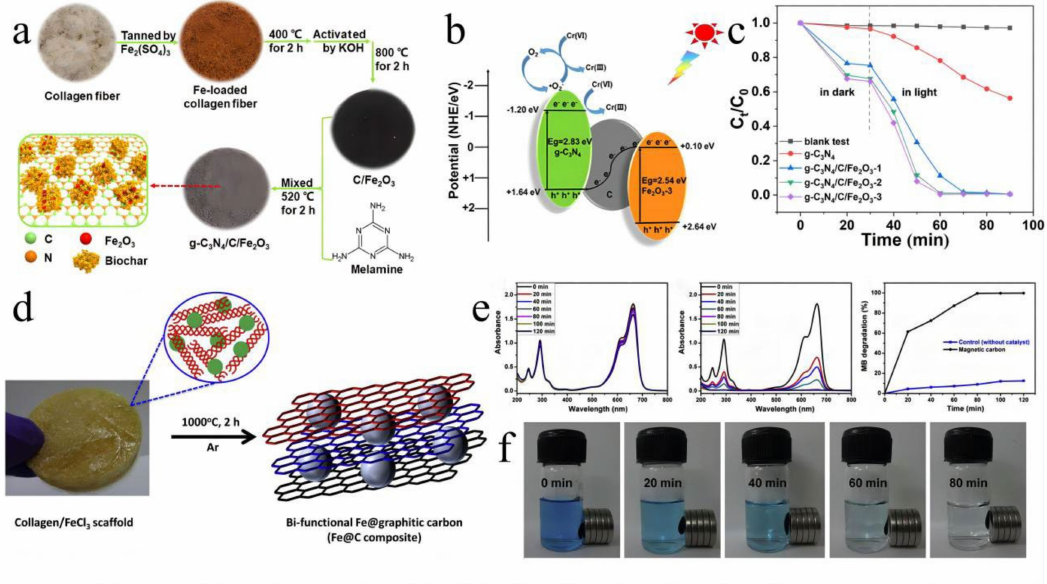
Figure 6. ( a ) Scheme for the fabrication of g − C 3 N 4 /C/Fe 2 O 3 , ( b ) schematic illustration of the reduction of Cr(VI) by g − C 3 N 4 /C/Fe 2 O 3 − 3 under light irradiation, ( c ) Cr(VI) reduction efficiency of different photocatalysts. Reprinted from Ref. [136] Copyright (2021) with permission from